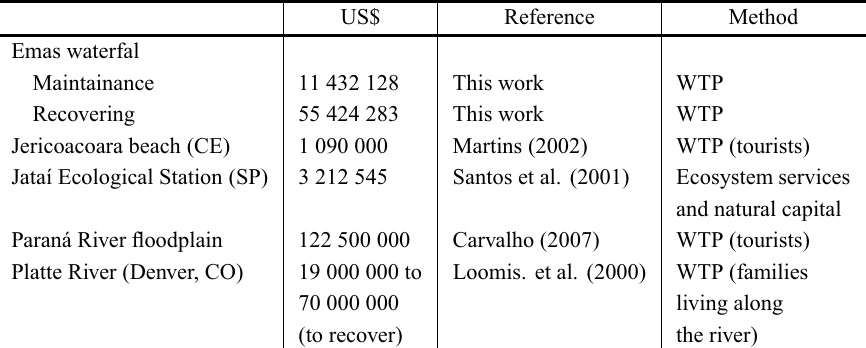
Comparison of the annual aggregated value of the Emas waterfall with that of other places. US$ Reference